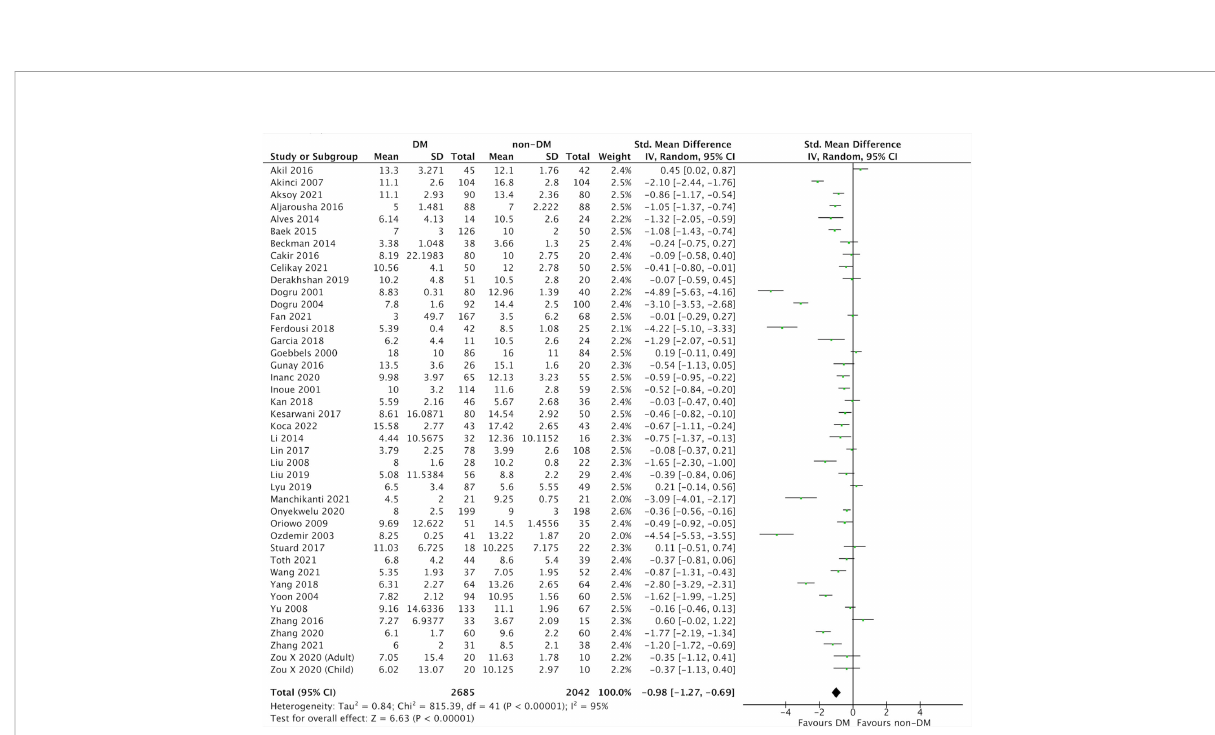
FIGURE 2 Comparison of the severity of dry eye disease (DED) between diabetes mellitus (DM) and non-DM based on invasive tear breakup time (ITBUT).